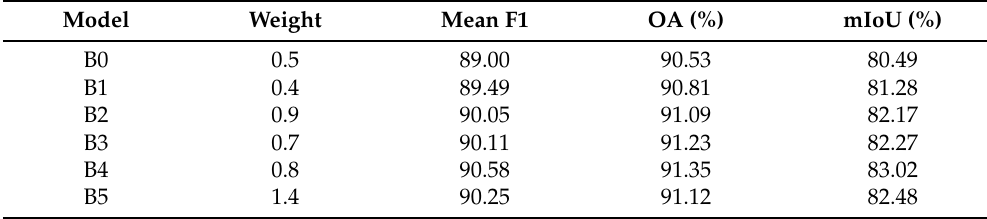
Table 5. Best weight setting of different models on Vaihingen test set.